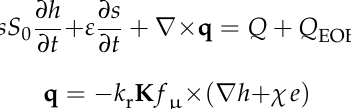
Figure 2. Variations of water level with time in the Jing river at the Zhangjiashan hydrometric station. The red dashed line is the average value of the surface water level.